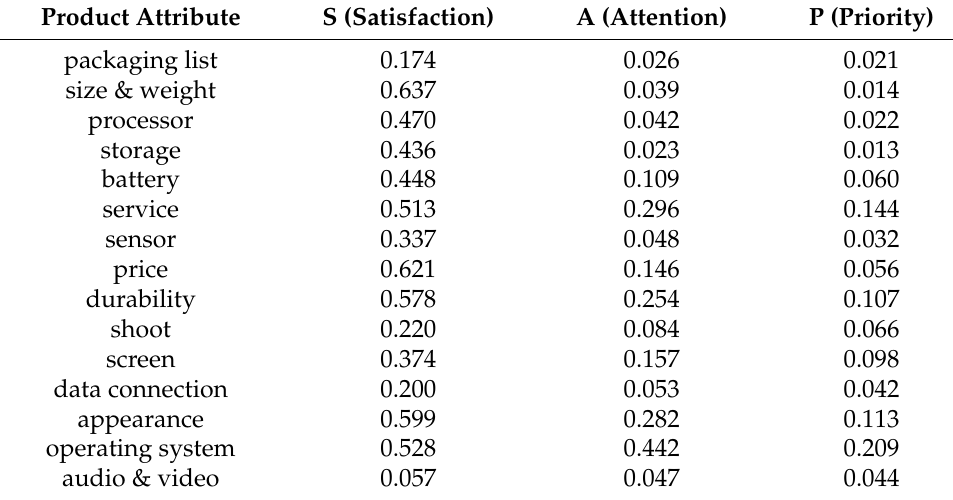
Table 8. Evaluation indicators for iPhone